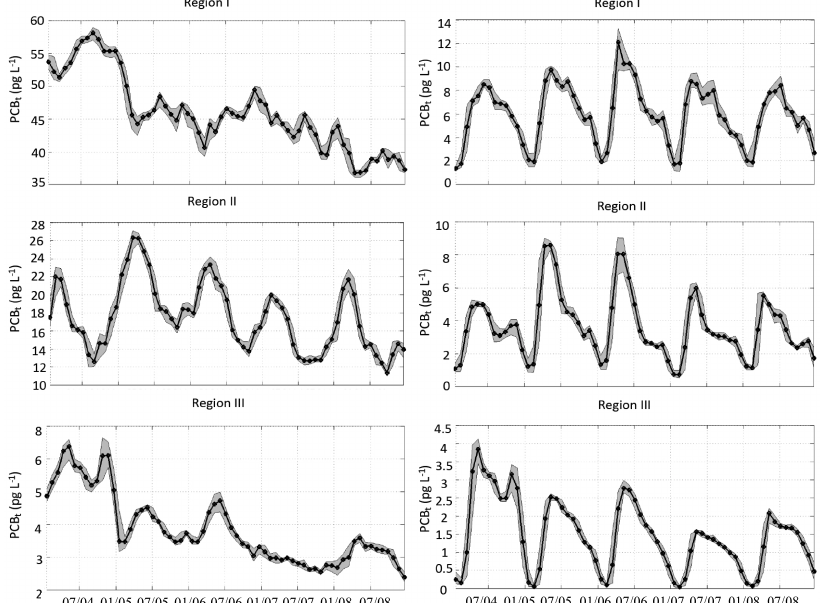
Figure 9. Temporal variability of the volume-averaged concentrations of total PCB t ( left ) and particulate PCB p ( right ) in the regions I ( top ), II ( middle ), and III ( bottom ) in 2004–2008 (for region separation, see Figure 1). (Note that the y -axis scales vary in magnitude.).